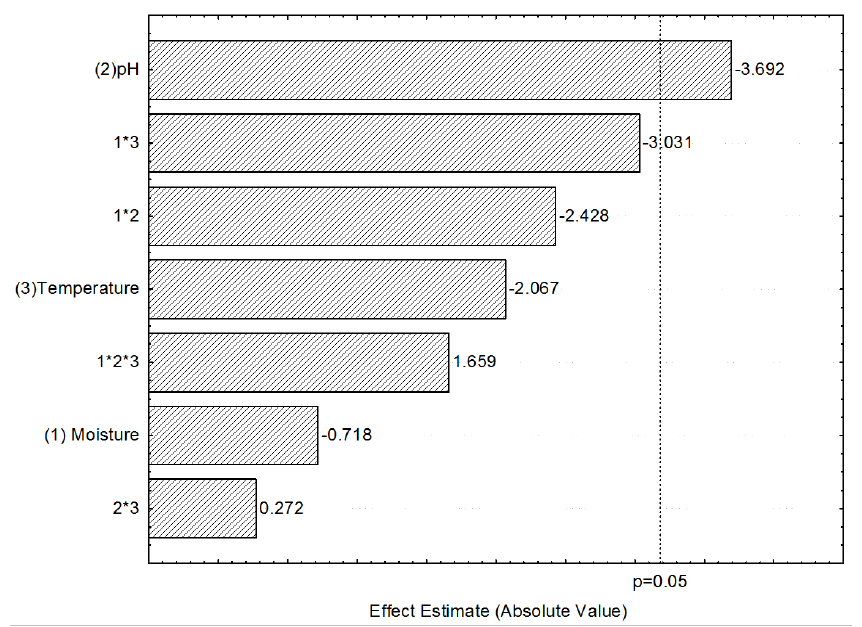
Figure 2. Pareto chart of main effects showing the production of xylanase during the 96 hours of fermentation of citrus pulp using three variables at two levels. The numbers in the ordinate of the figure refer to: (1) Moisture - percentage of water content, (2) pH and (3)